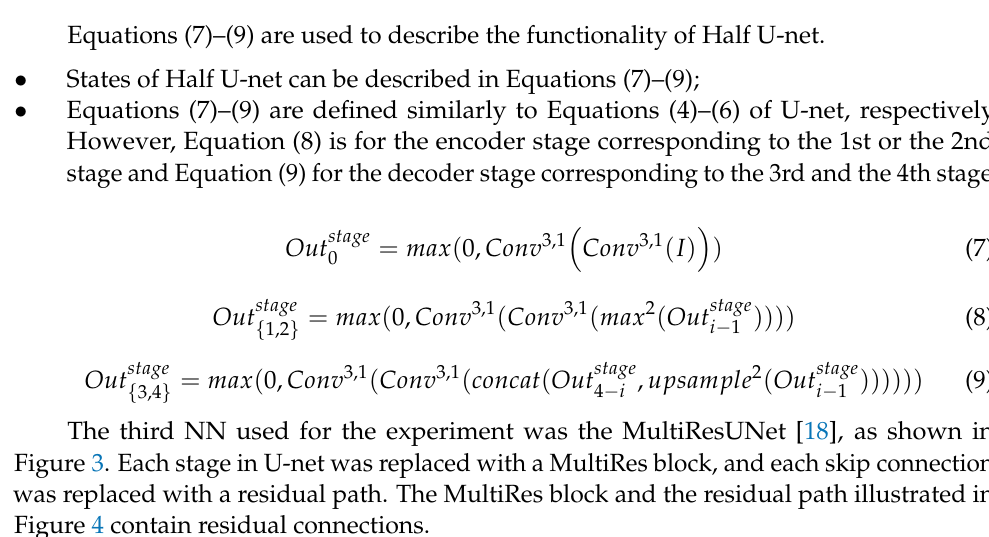
Figure 2. Half U-net.